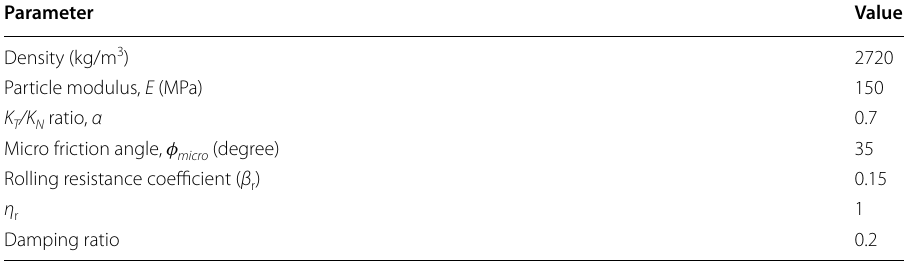
on the pipe and comparing the results with existing analytical solution [17]. The radial earth pressure on the pipe is calculated at five different locations (Invert, lower haunch, springline, upper haunch and crown) and then compared with the values obtained using